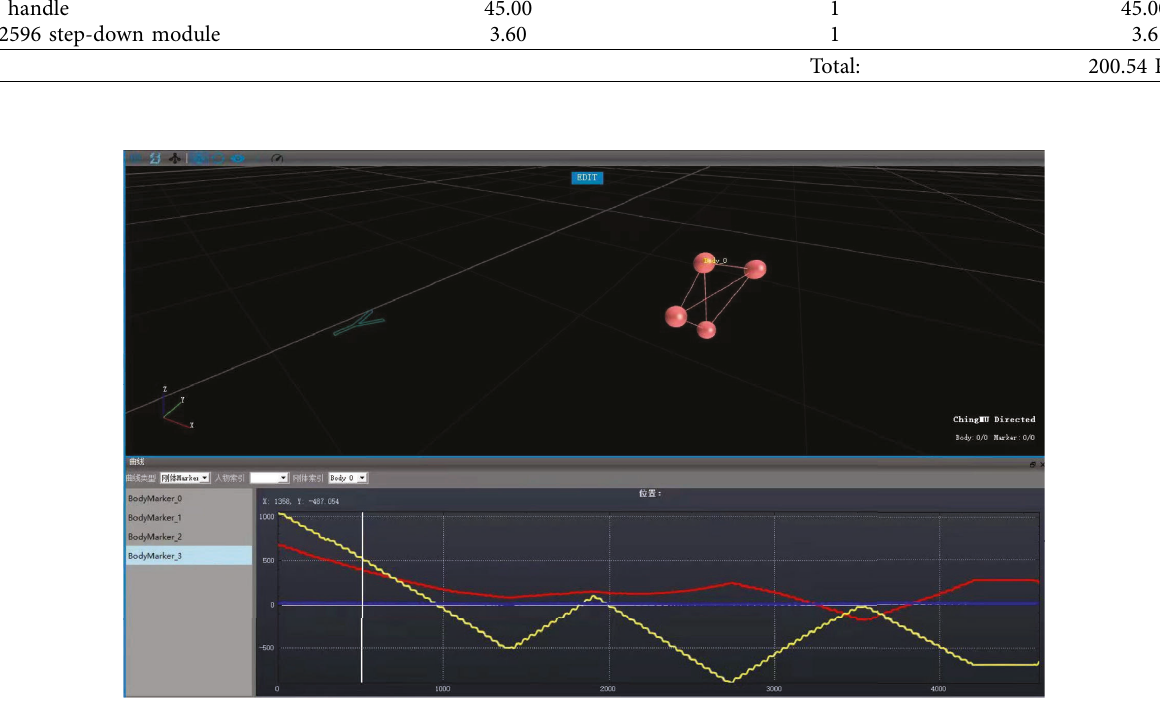
Figure 15: The experiment in the motion capture system.